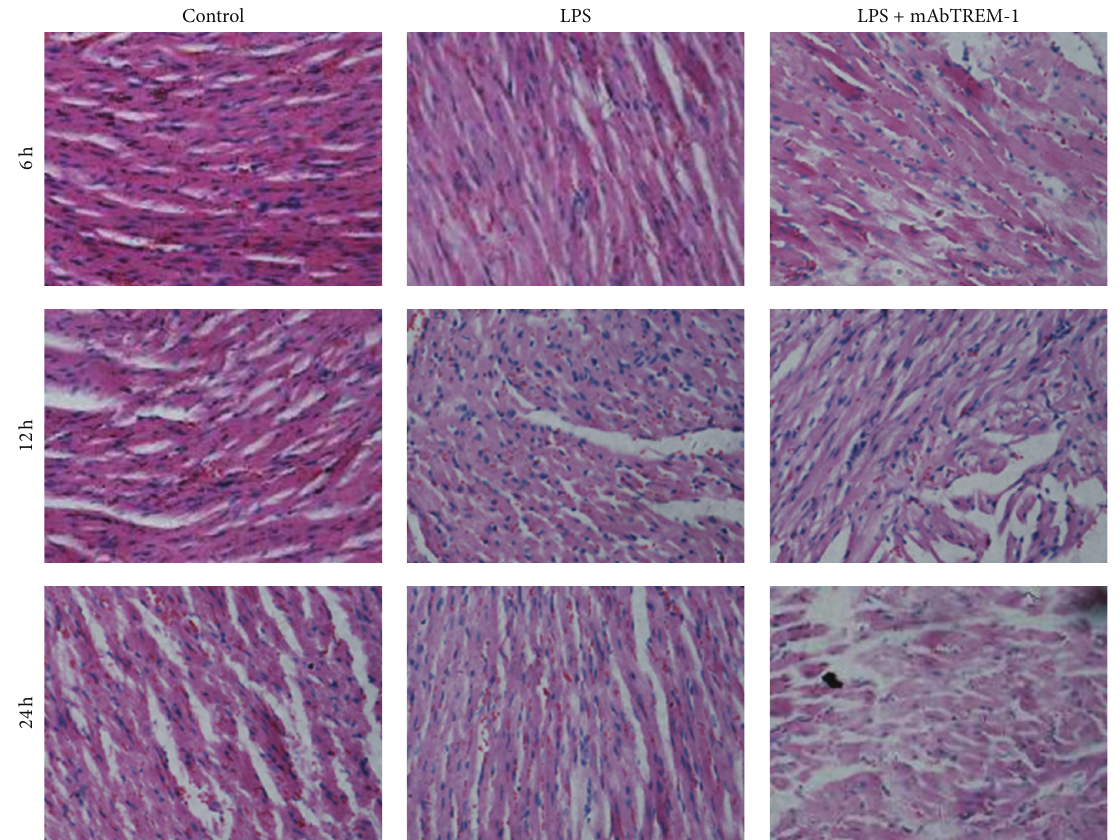
Figure 4: Morphological analysis of myocardial damage among 3 groups at 6 h, 12 h, and 24 h as described in Materials and Methods. Magnification × 400, extensive interstitial edema, infiltration of inflammatory cells, and hemorrhage in LPS-treated mice. Note that mabTREM-1 induced myocardium damage is markedly increased in LPS/mAbTREM-1-treated mice compared with saline-treated mice or LPS-treated